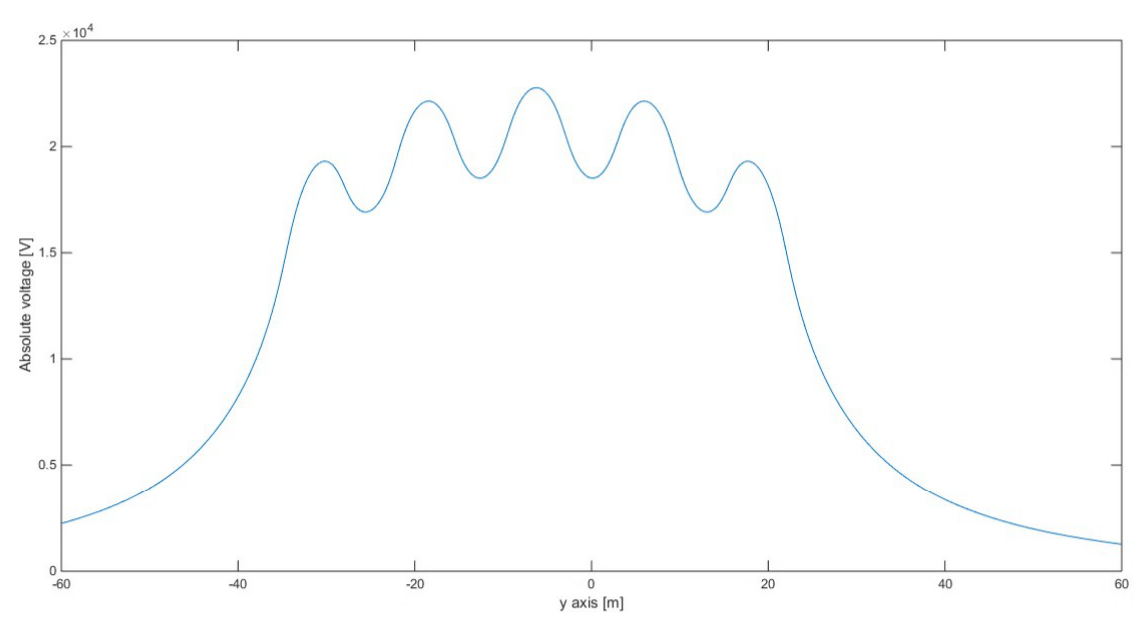
Figure 30. Absolute electric potential on the perceived axis of the electrode station (for x = 0 on the yOy’ axis, applying method “A” for the far field ( ρ S = ∞ ) and method “C” for the near field, with simplifying admissions ( ρ S = ∞ ), with compensation for the presence of a dam), for an electrode station of 6 linear frames in a row, with d frames = 6.50 m, each frame consisted of 13 electrodes of active length L = 2.13 m, D el = 0.50 m, ρ d = 100 Ω · m, ρ w = 0.25 Ω · m, θ w = 2.29 ◦ , θ = 248 ◦ (area of Korakia),